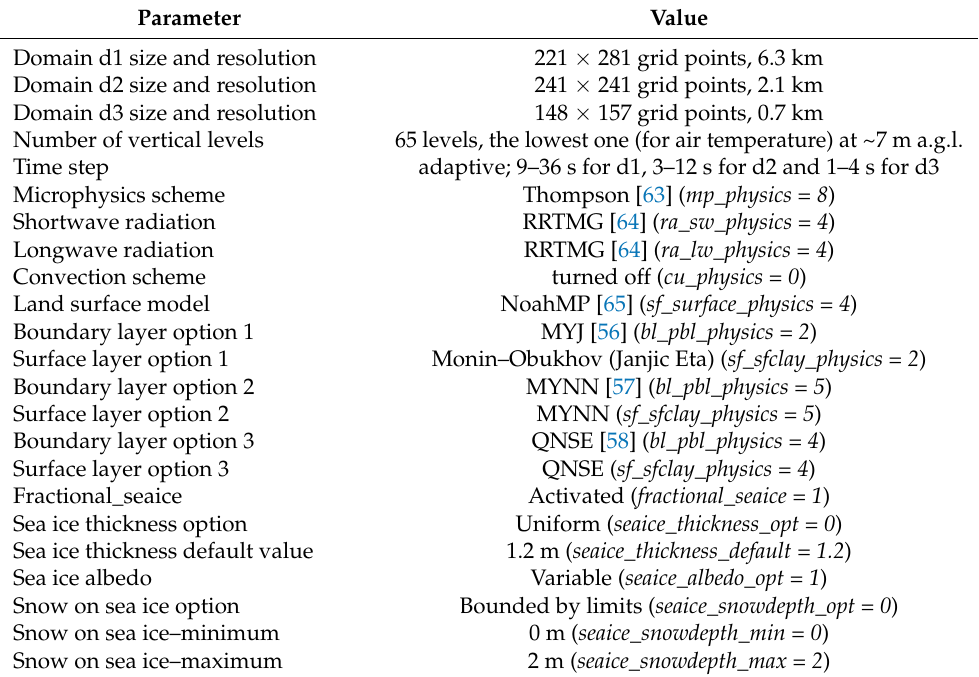
Table 2. The Weather Research and Forecasting (WRF) model configuration. For model physics, also the name-list entries are